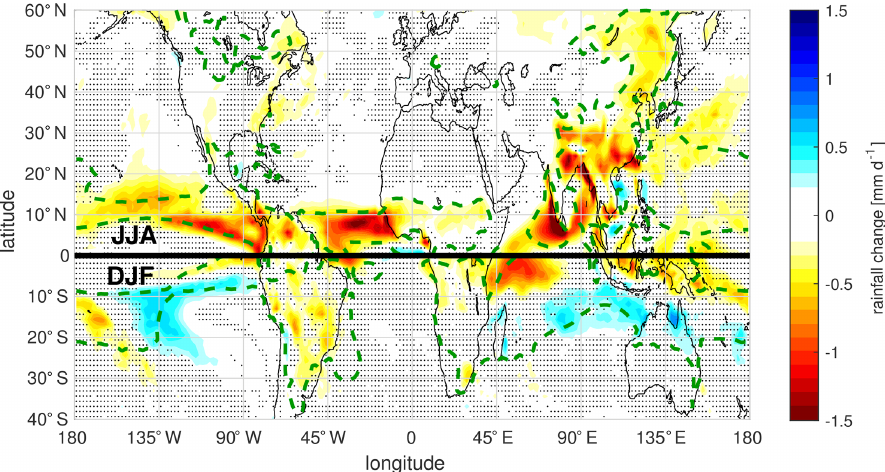
Figure 5. The difference in monsoon rainfall (in mmd − 1 ) across the range of the scaling factors ( × 1 . 5 minus × 0 . 2). The summer months are shown in each hemisphere (June–August in the NH, December–February in the SH); the thick black line marks the Equator. Averaged over the period 1950–2014 and across all ensemble members. The green dotted line indicates the mean GMA in the × 1 . 0 experiment. Spots indicate regions where the rainfall difference is insignificant with respect to variability across years and